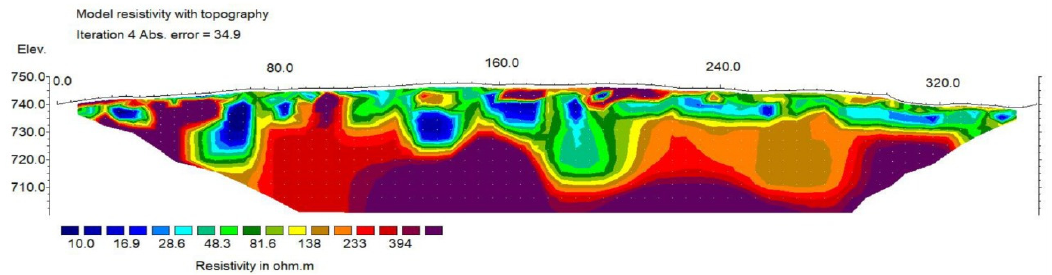
Figure 5. The modeled resistivity sections for APA01 ERT (Tarimba cave) profile. Color bar presents resistivity values in ohm.m.